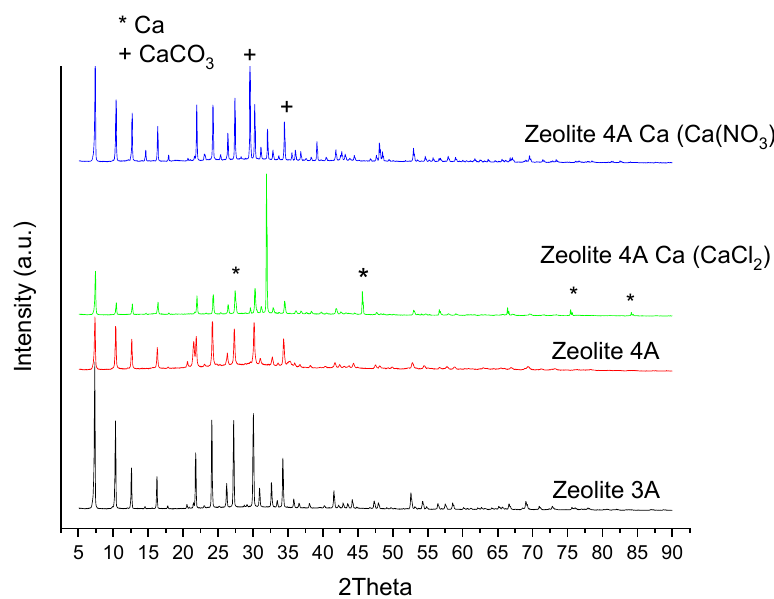
Figure 9. XRD patterns of calcined zeolite 3A, zeolite 4A and zeolite 4A Ca (CaCl 2 ).